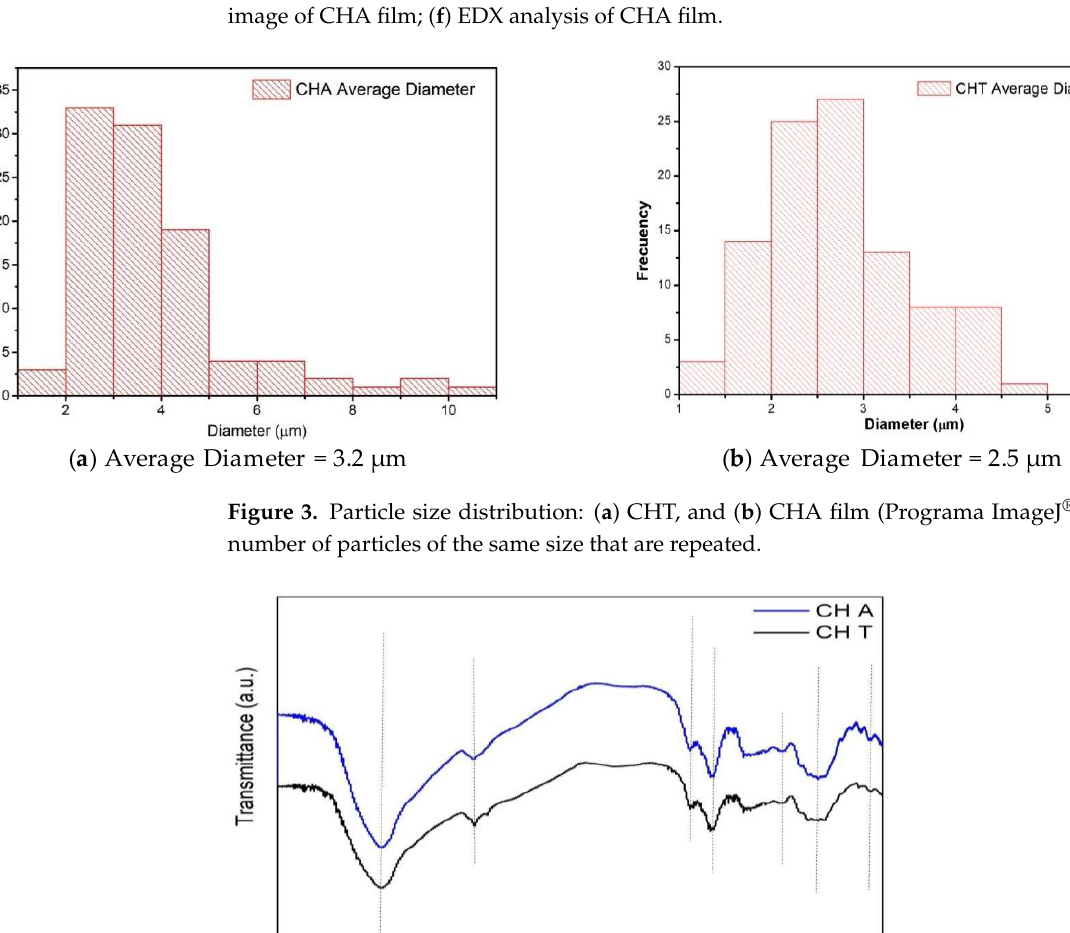
Figure 4. FTIR spectra of chañar Gums. Table 2. Principal absorbance bands of FTIR spectra of CHT and CHA gums [46,58 – 63]. Bands Posi- tion